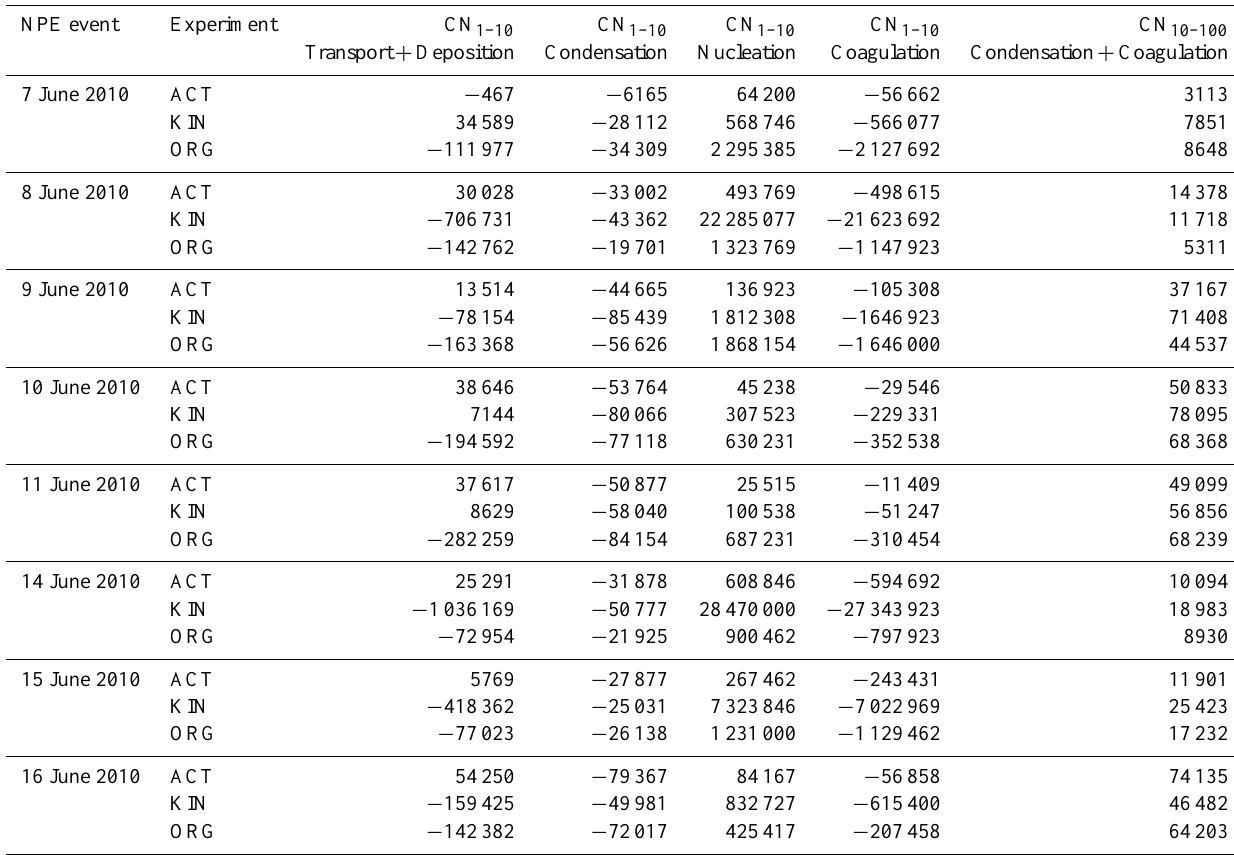
Table 3. Selected budget diagnostic terms (cm − 3 h − 1 ) for all NPE days at the T0 and T1 sites, averaged over 04:00–16:00PST on each day. The CN 1–10 Transport + Deposition term includes advection, turbulent mixing, and dry